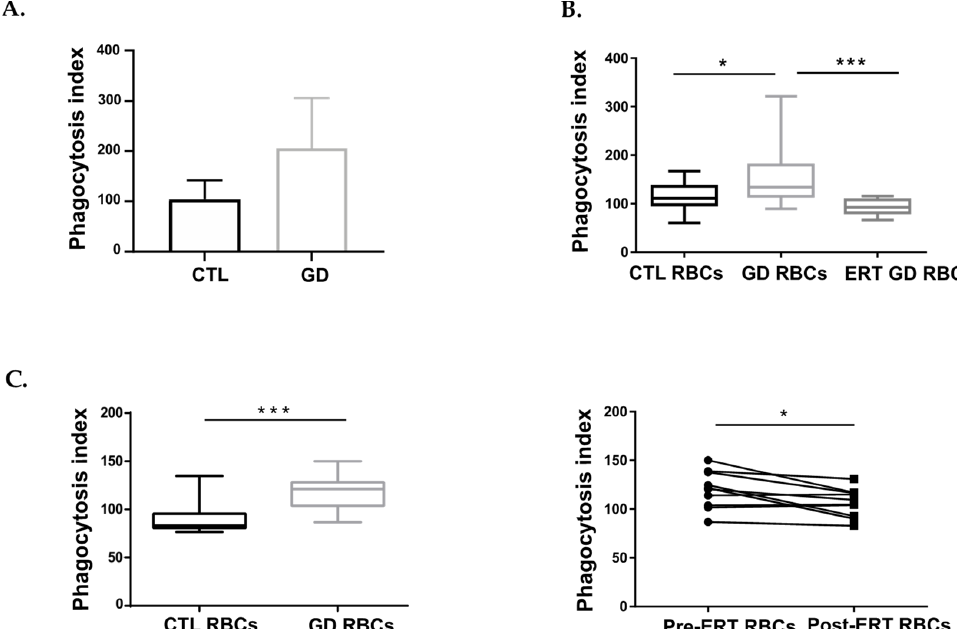
Figure 1. GD RBCs exhibit higher phagocytosis index (PI) by macrophages than CTL RBCs. ( A ) Erythrophagocytosis assays were performed using primary macrophages derived from healthy donor’s monocytes (CTL) or monocytes-derived macrophages from untreated GD patients (GD) and polarized toward the M2 phenotype. CTL macrophages were co-incubated with the autologous CTL RBCs ( n = 3) and GD macrophages were co-incubated with the autologous GD RBCs ( n = 3). The chart represents the PI of CTL and GD samples. The means and standard deviation are represented. ( B ) Erythrophagocytosis assays were performed using primary macrophages derived from healthy donor monocytes and polarized toward the M2 phenotype. The chart represents the PI of CTL samples (CTL RBCs; n = 15) and untreated GD samples (GD RBCs; n = 15), and treated GD samples (ERT GD RBCs, n = 8). Group comparison was performed using a Mann-Whitney test. The medians are represented as horizontal bars; the upper and lower quartiles are represented as the top and the bottom of the box, respectively; and the maximum and minimum data values are shown by dashes at the top and the bottom, respectively, of the whiskers. * p < 0.05; *** p < 0.001. ( C ) Left panel: Erythrophagocytosis assays were performed using THP1-derived macrophages co-incubated with CTL RBCs ( n = 11) or GD RBCs ( n = 18). The chart represents the PI of CTL and GD RBCs obtained for this cohort. Group comparison was performed using a Mann-Whitney test. The medians are represented as horizontal bars; the upper and lower quartiles are represented as the top and the bottom of the box, respectively; and the maximum and minimum data values are shown by dashes at the top and the bottom, respectively, of the whiskers. *** p < 0.001. Right panel: Erythrophagocytosis assays were performed using THP1-derived macrophages. The effect of ERT treatment on the PI was evaluated for RBCs from 10 patients before (Pre-ERT RBCs) and after (Post-ERT RBCs) ERT treatment (longitudinal study). Group comparison was performed using a paired t -test. * p < 0.05.